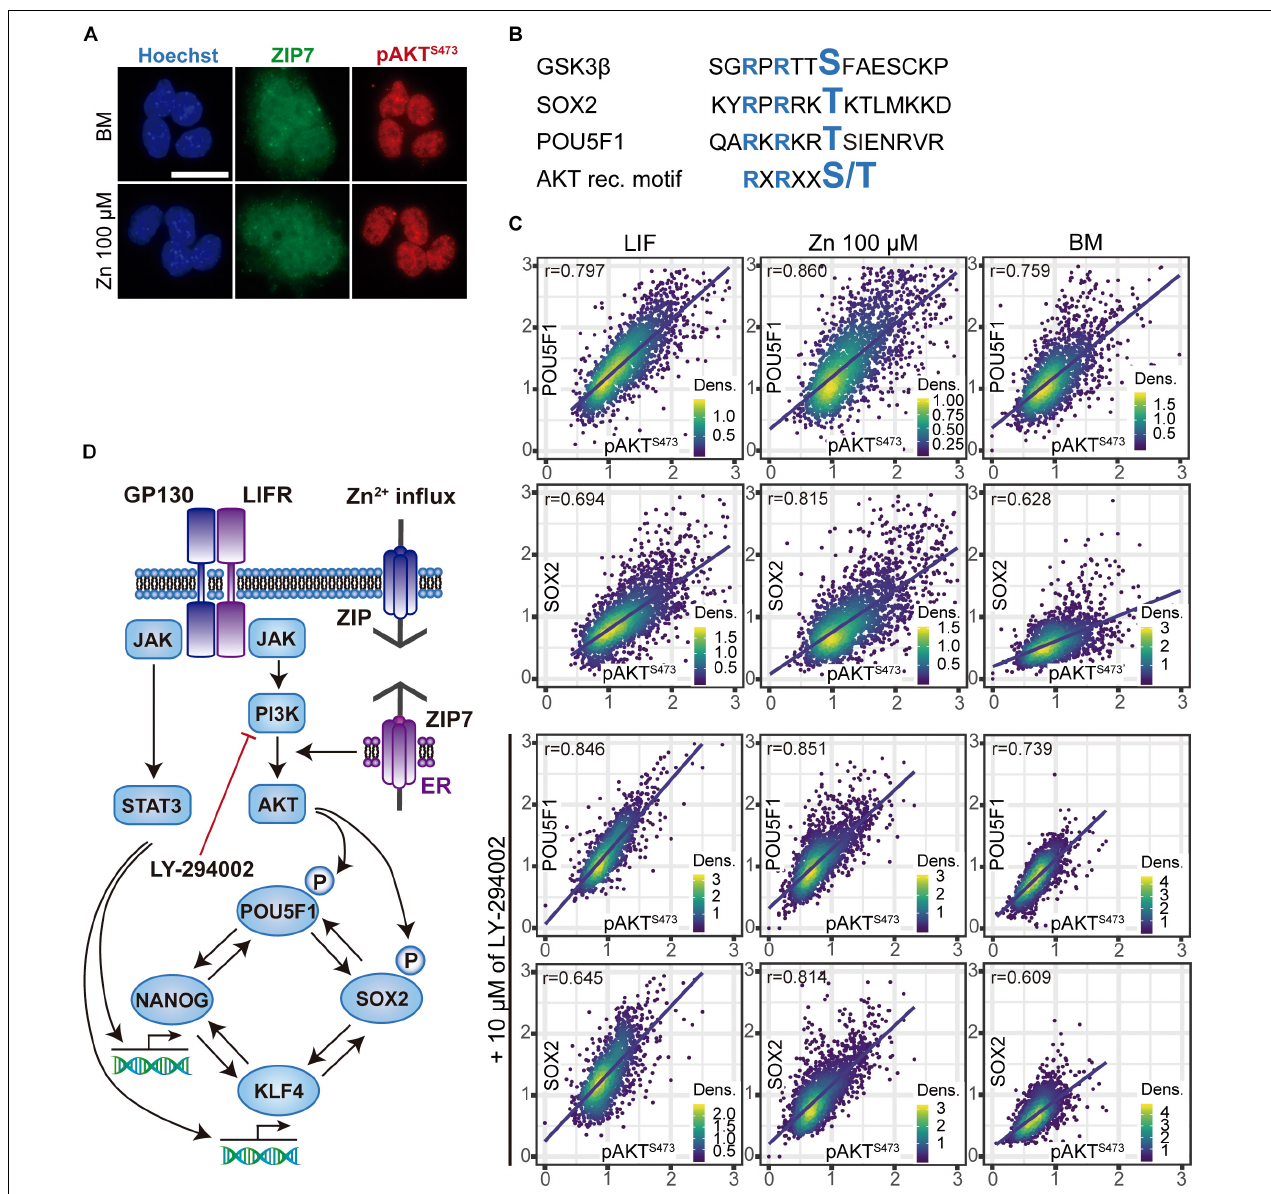
FIGURE 3 | Relationship between nuclear pAKT and the core transcriptional network for ESC self-renewal. (A) Immunostaining of Zn 2 + transporter ZIP7 and pAKT (S473) in ESCs cultured for 24 h in BM only or BM supplemented with 100 µ M of Zn 2 + . Scale bar: 50 µ m. (B) Alignments of aminoacid sequences of mouse GSK3 β , POU5F1, and SOX2 showing the target motifs for AKT-mediated phosphorilation. NetPhos 3.1 Server was used to identify these sequences, which then were aligned with the minimal recognition motif of AKT. (C) Immunofluorescence detection and quantification of pluripotency markers POU5F1, SOX2, and pAKT (S473) in ESCs cultured for 3 days in normal medium and medium supplemented with 10 µ M of PI3K inhibitor LY-294002. Obtained data were represented and Pearson’s correlation r -values were obtained using R. (D) Proposed mechanism illustrating the effects of Zn 2 + in AKT phosphorylation and ESCs self-renewal. Addition of extracellular Zn 2 + in the culture medium, activate ZIP7 and AKT downstream pathways. Note that these results have been determined experimentally in this work and the illustrated steps activated by AKT to maintain ESCs pluripotency have been previously reported in the literature (Saxe et al., 2009; Jeong et